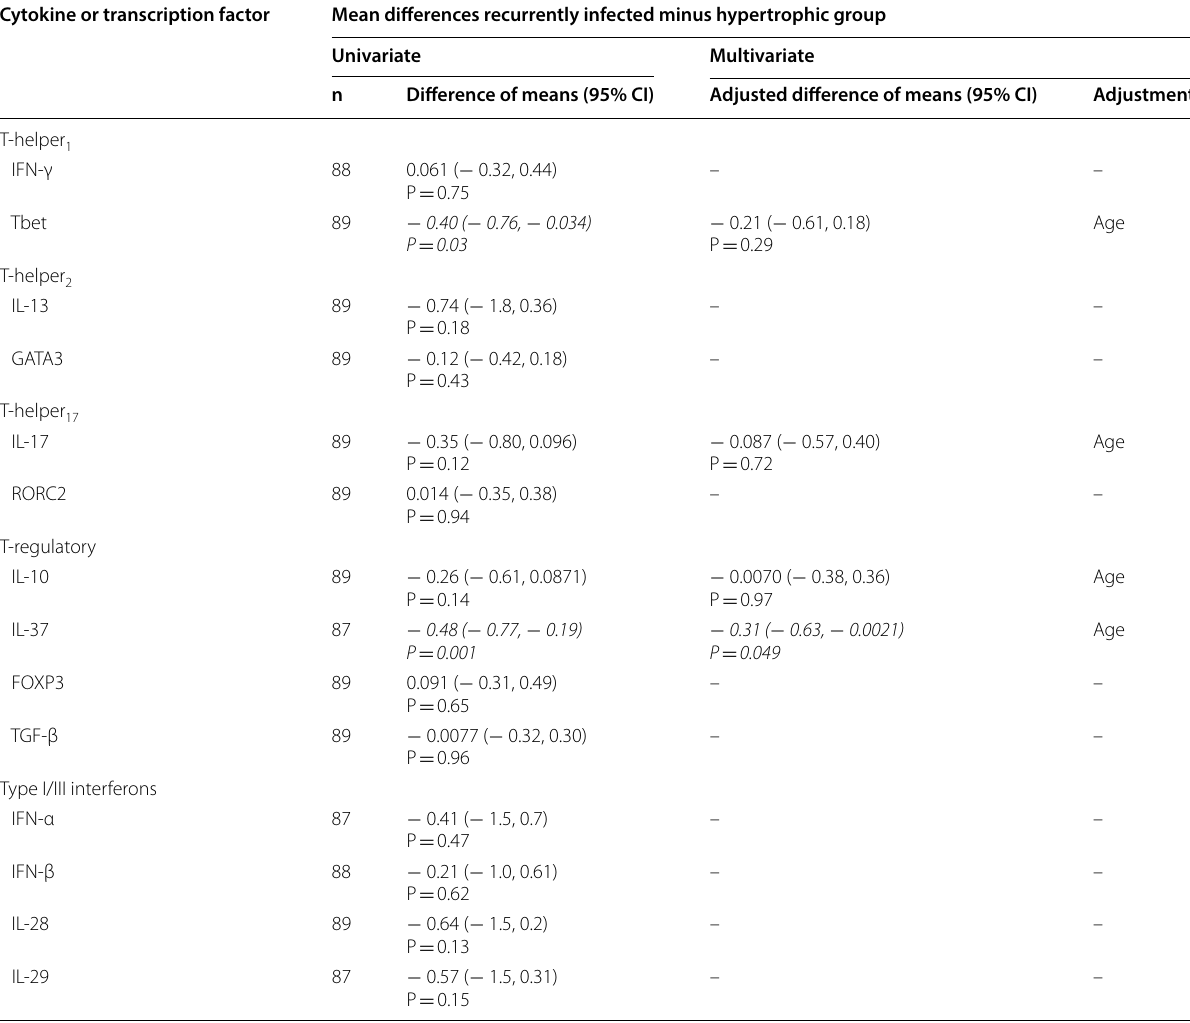
Data are expressed as mean differences as a recurrently infected group minus hypertrophic group. The data were analysed using backward stepwise linear regression analysis after logarithmic transformation. Only significant co-factors were used as adjustments in the final model CI, confidence interval; IFN, interferon; Tbet, T-box transcription factor; IL, interleukin; GATA3, GATA-binding factor 3; RORC, RAR-related orphan receptor C; FOXP, forkhead box protein; TGF, tumour growth